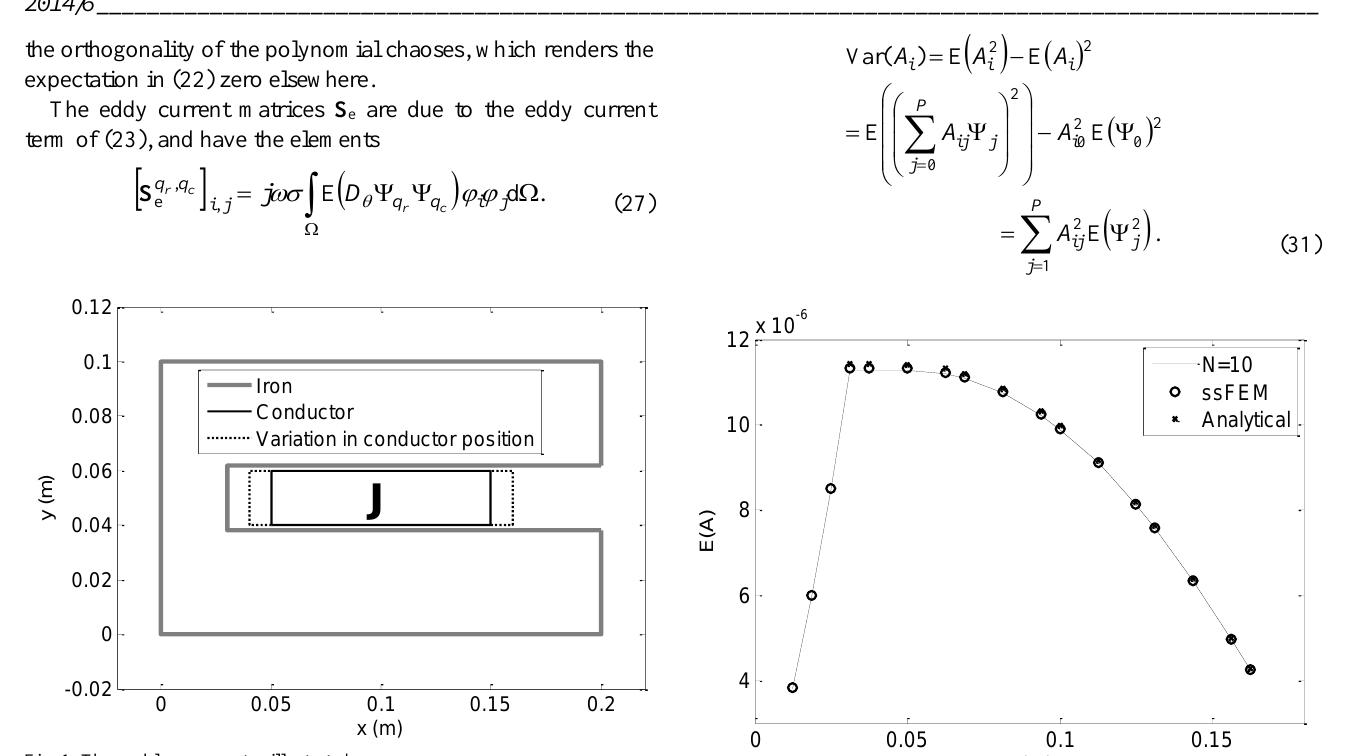
Fig. 1. The problem geometry illustrated.